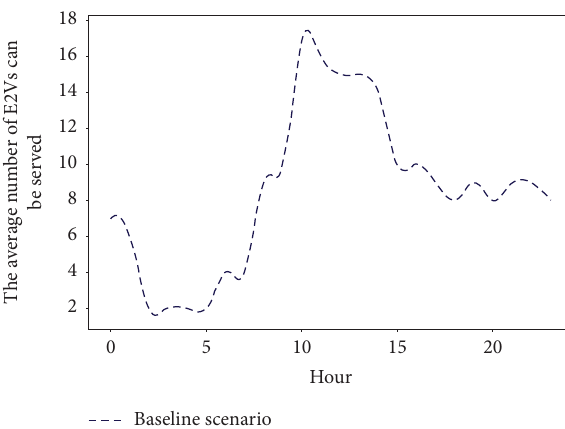
Figure 24: Simulation results in the basic scenario.